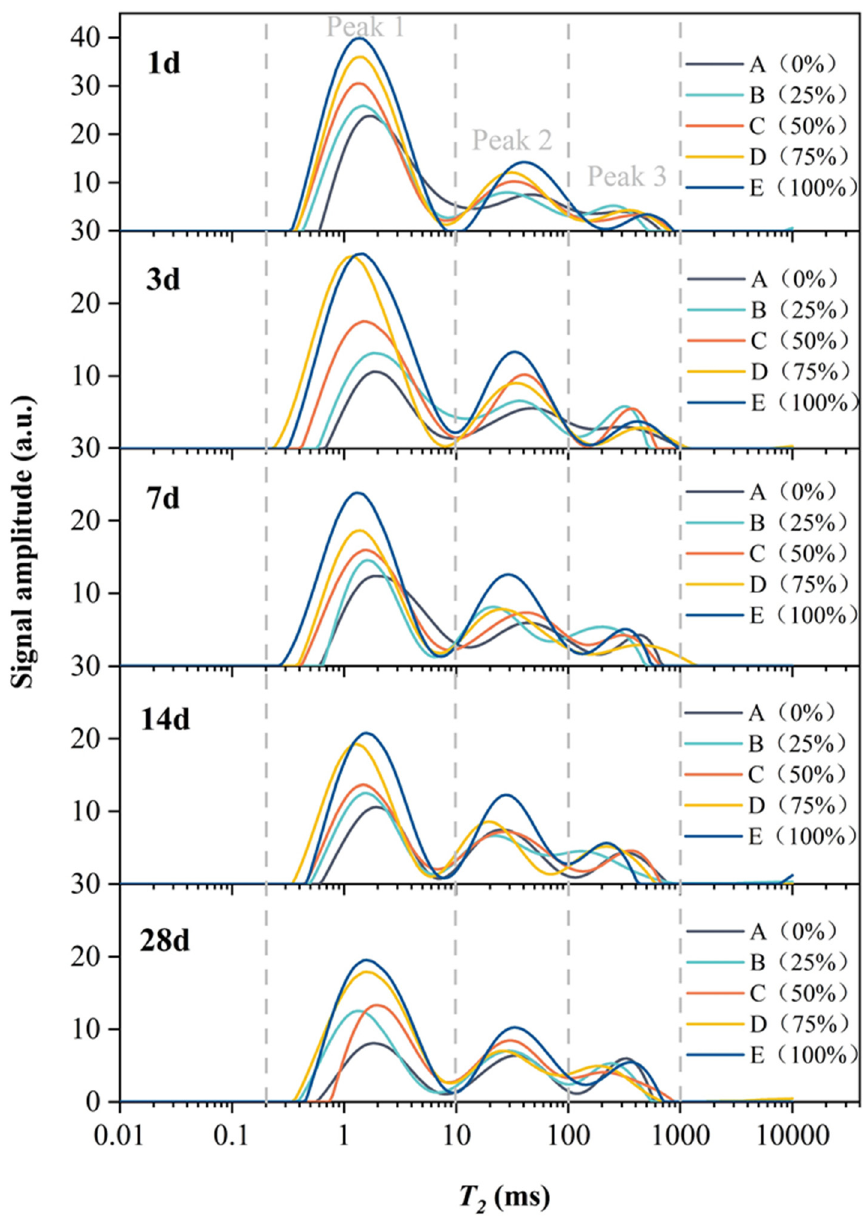
Figure 7. Evolution of T 2 spectra of concrete fluids with different silica fume replacement amounts at different ages.